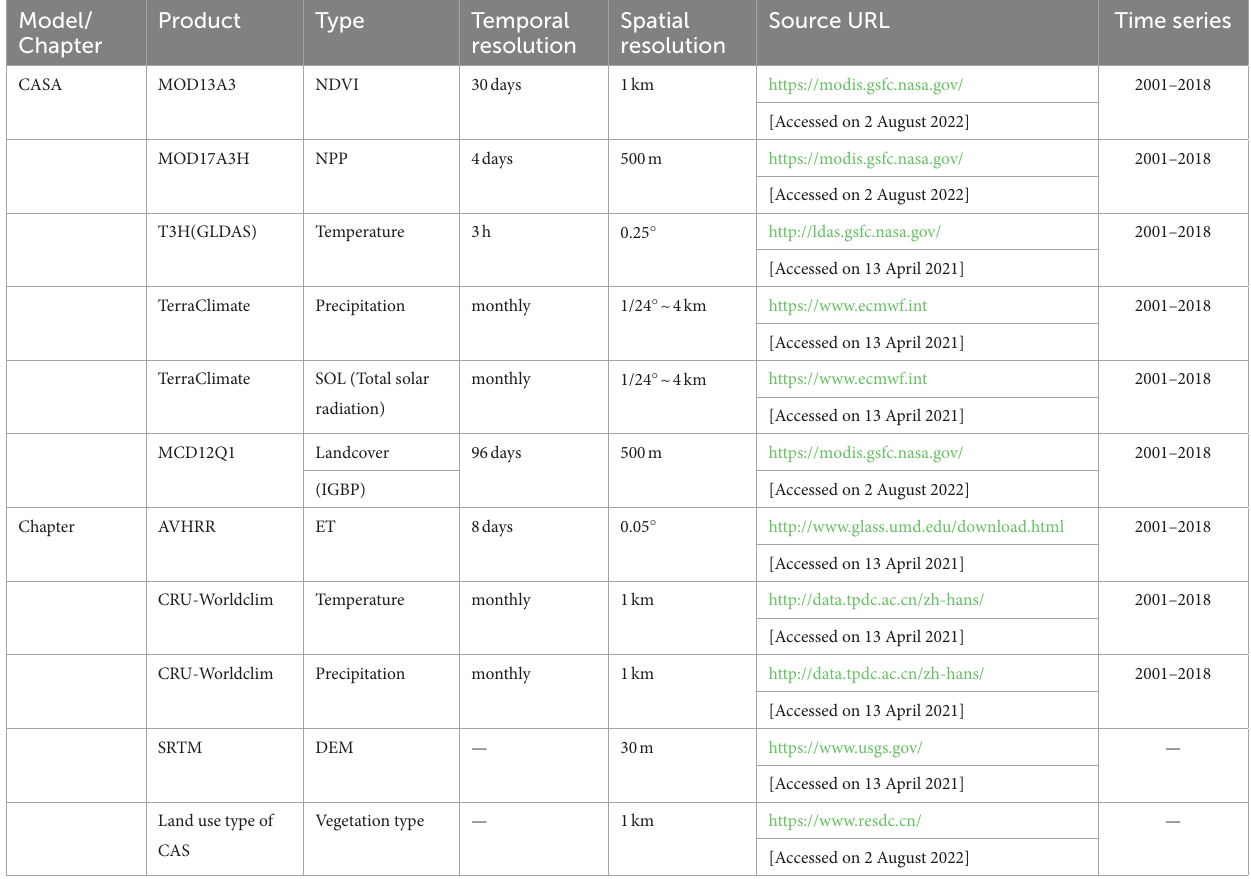
TABLE 1 Data product type and